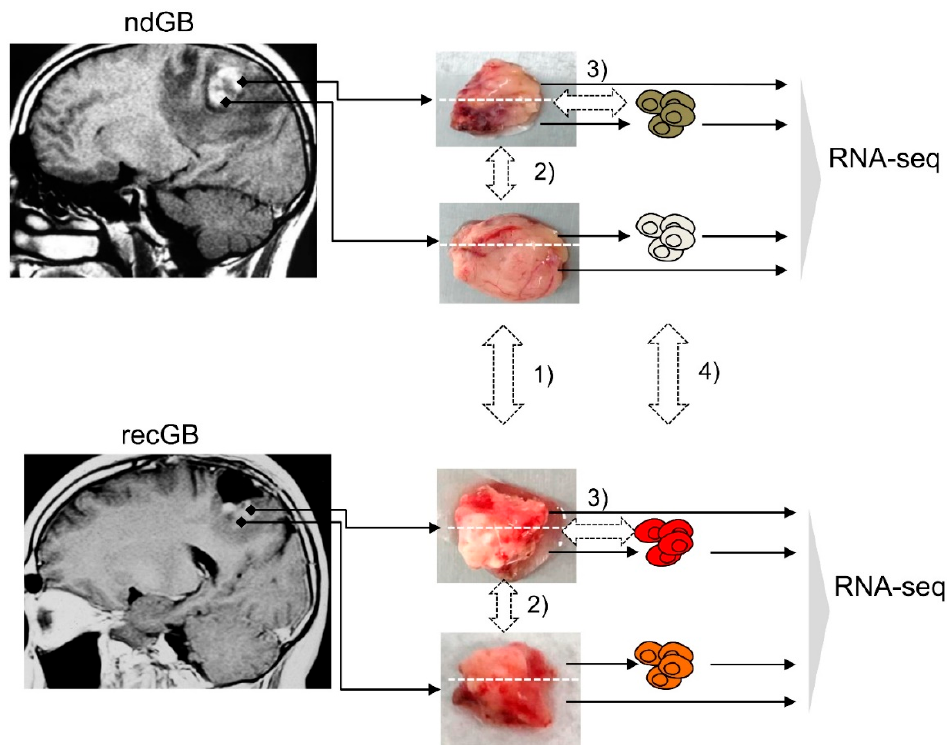
Figure 1. Study design. Tissue blocks were resected from newly diagnosed glioblastomas (ndGBs) or recurrent GBs (recGBs) using a multisampling approach. Each block was portioned and processed either for a direct sequencing of tissue RNA or glioma stem cell (GSC) isolation. RNA-seq of tissue samples or primary cultures of GSCs was followed by bioinformatic analysis to compare gene expression along the following lines: (1) ndGB vs. recGB tissues; (2) between different regions from the same tumor; (3) tissue biopsies vs. GSCs; (4) GSCs from ndGBs vs. GSCs from recGBs.